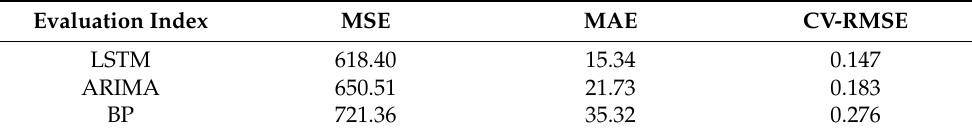
Table 2. Results of different models forecasting daily air-conditional electricity consumption.